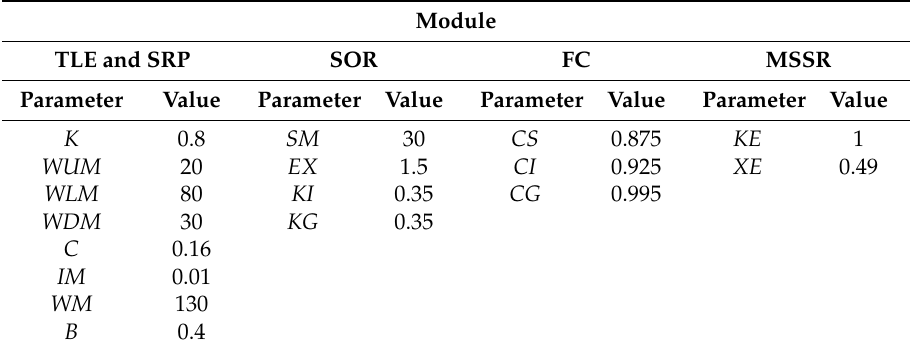
Table 3. Parameters of the XAJ model used in the numerical